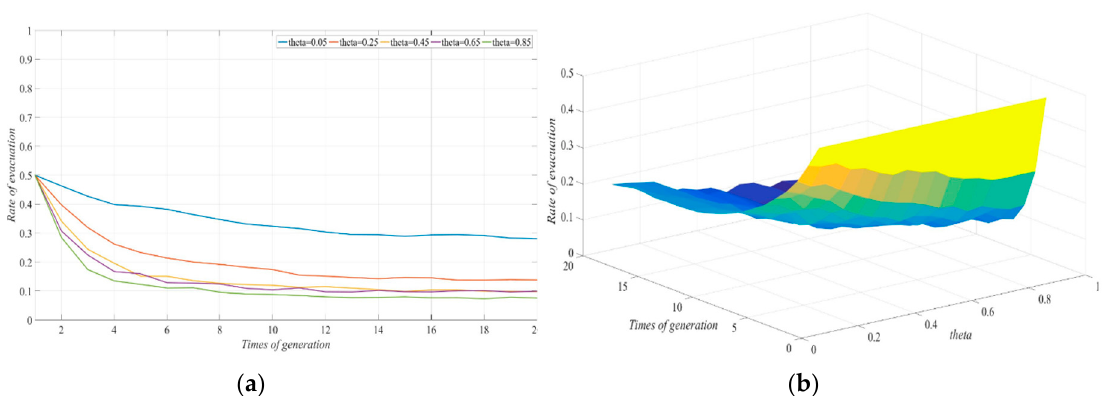
Figure 6. Effect of changes in θ on the evolution of evacuation systems: ( a ) two-dimension; ( b ) three-dimension.